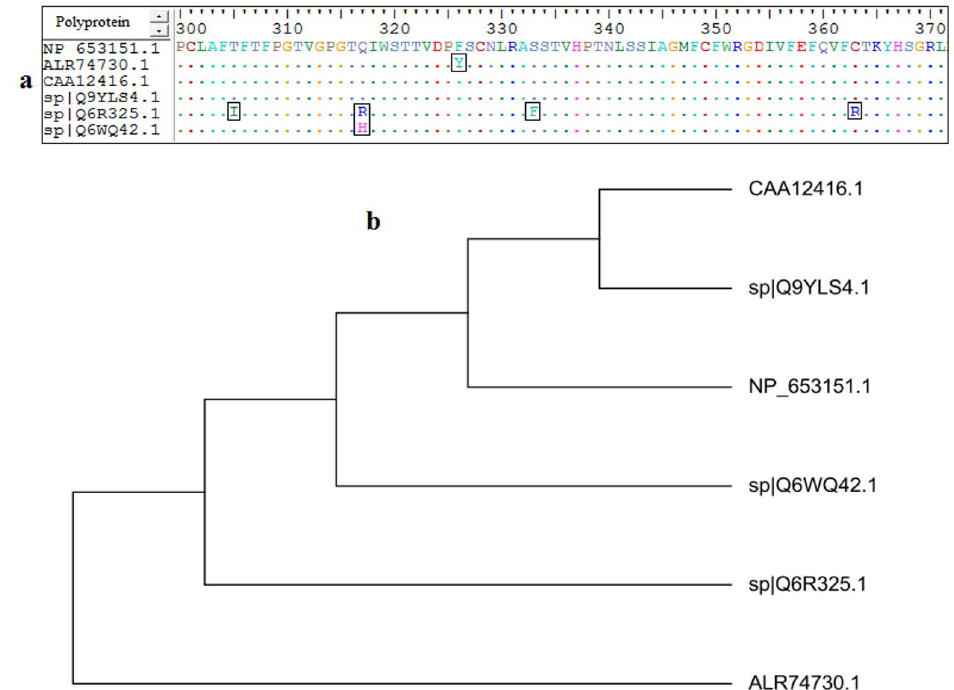
Fig. 1. (a): MSA was performed using Bioedit software. Dots within the sequences indicated conservancy, while letters within squares indicated non conserved regions. (b): the phylogenetic tree showed molecular divergence between the